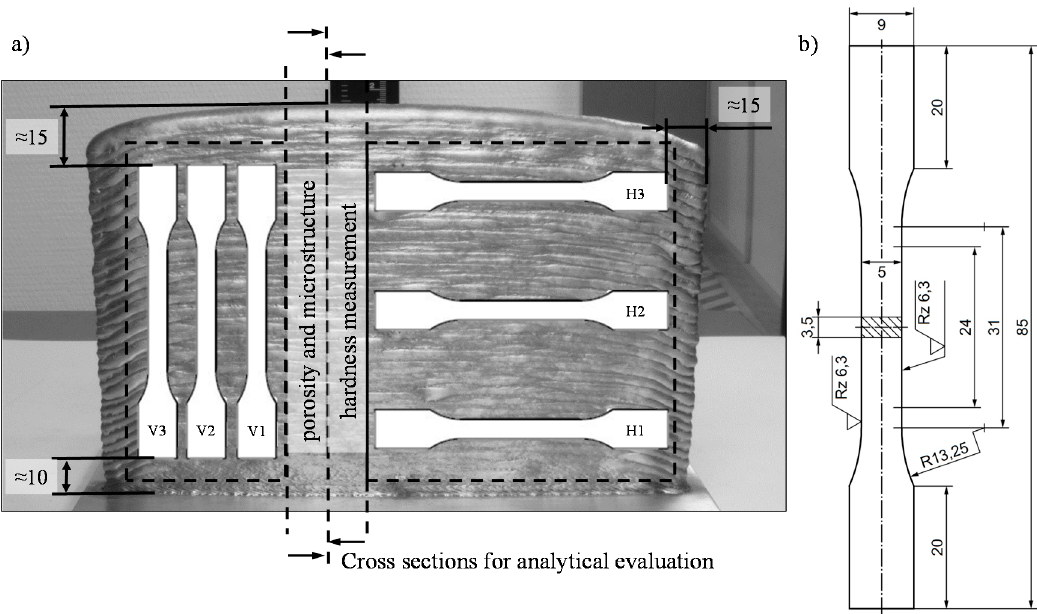
Figure 3. ( a ) Schematic representation of the arrangement of the tensile specimens vertically (V) and horizontally (H) to the buildup direction, as well as the wall segments to evaluate hardness, porosity and the final contour and ( b ) dimension of the tensile specimen of form E according to DIN 50125:2016-12.